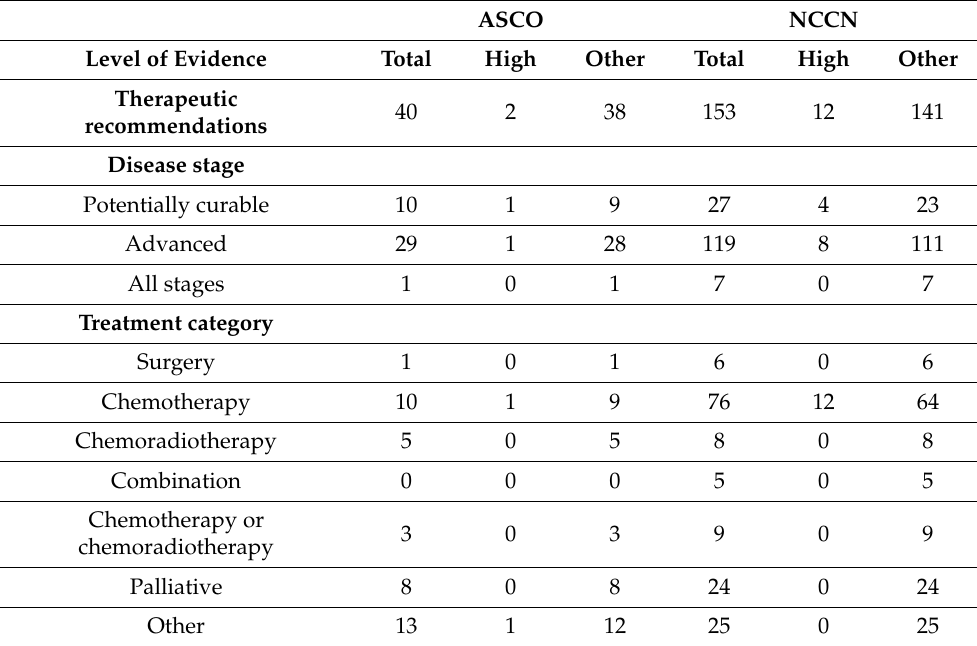
Table 1. Number of therapeutic recommendations in current pancreatic adenocarcinoma guidelines, overall and by categories (disease stage and type of